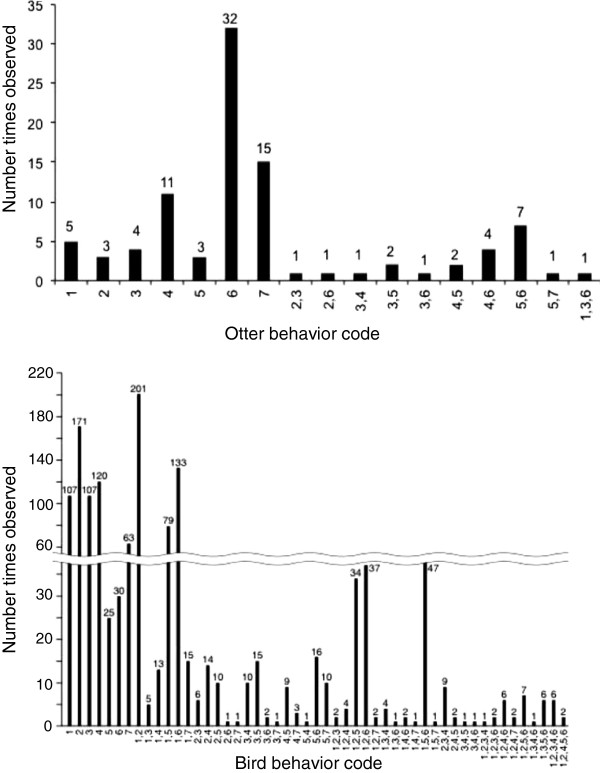
The number of times different numerically coded behaviors (see Table1for code definitions) or combinations of behaviors were observed for sea otters (top) and birds (bottom). The numbers at the top of bars are the total number of observations of each behavior.